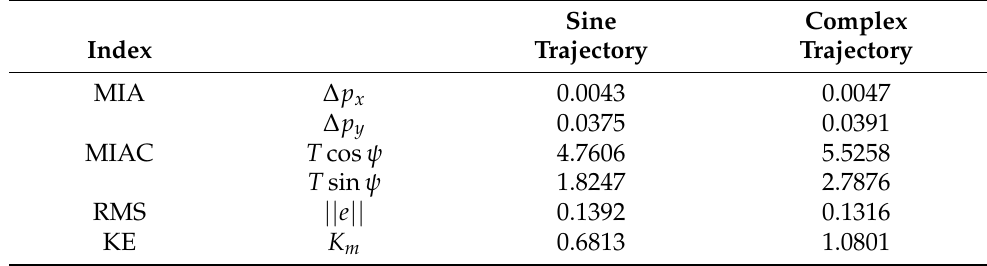
Table 4. Performance for classical controller (with friction).